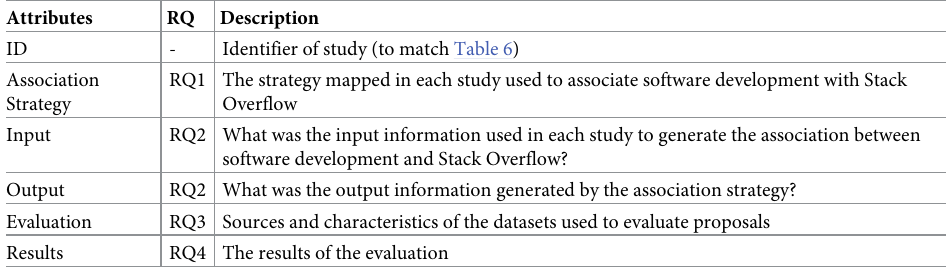
Table 3. Attributes extracted from selected